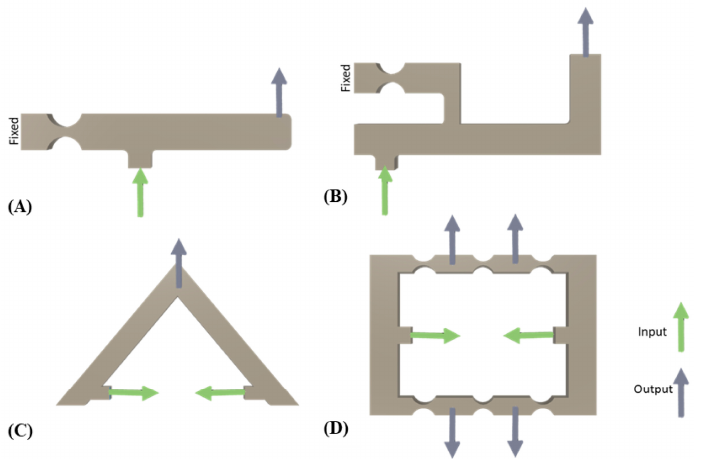
Figure 8. Various types of displacement amplifying structures [40]. ( A ) Lever type; ( B ) Scott-Russell type; ( C ) Buckling type; ( D ) Bridge type.